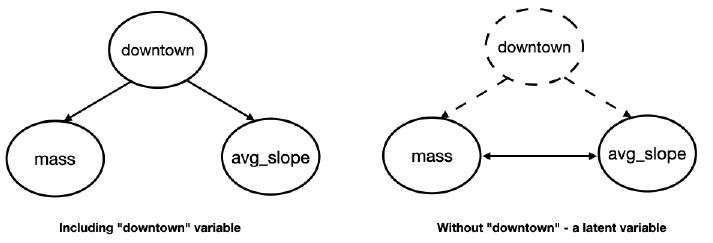
Figure 2. Detail of the uncertainty in Bayesian networks due to the presence of a latent